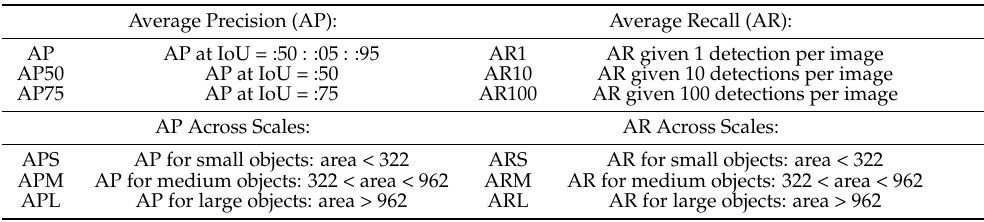
Table A1. Object detection evaluation criteria. AP, AP50, AP75, APS, APM, APL, AR1, AR10, AR100, ARS, ARM, ARL for MS-COCO dataset.